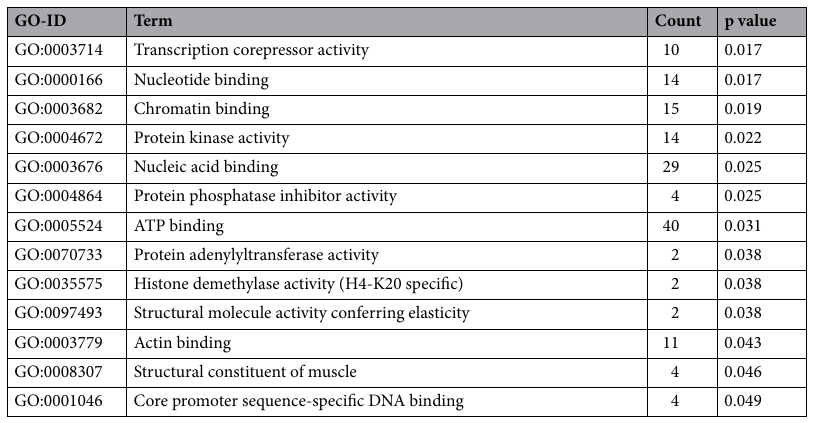
Table 3. GO analysis of DEGs.